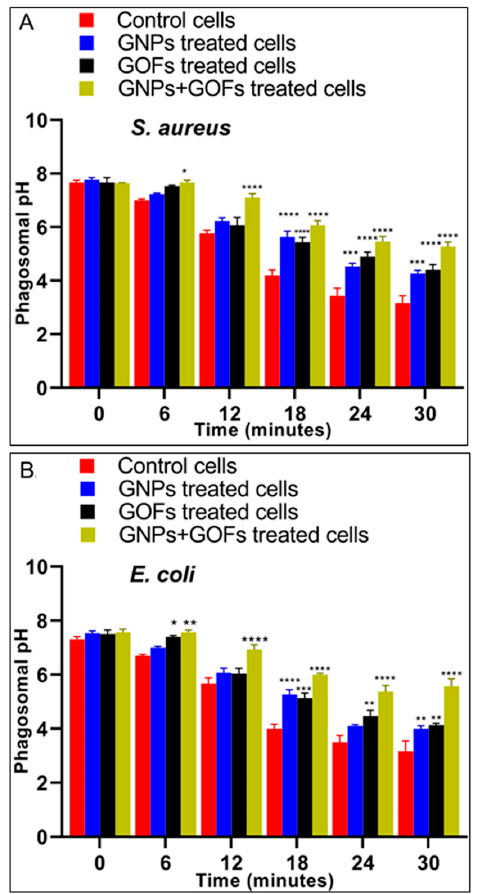
Figure 4. GNPs and GOFs induce phagosome maturation in BMDMs. Phagosomal pH was measured in control, untreated BMDMs, pretreated with GNPs and GOFs as indicated, after being chased with fluorescent probe-coupled Staphylococcus aureus or Escherichia coli . Data are represented as mean ± SE. Statistical significance by two-way ANOVA ( p < 0.0001) followed by posthoc testing using Tukey’s multi group comparison with control cells: * p = 0.03, *** p = 0.002, **** p < 0.0001 indicate statistically different for ( A ) S. aureus while * p = 0.03, ** p < 0.01, *** p = 0.002, **** p < 0.0001 indicate statistically different for ( B ) E. coli .